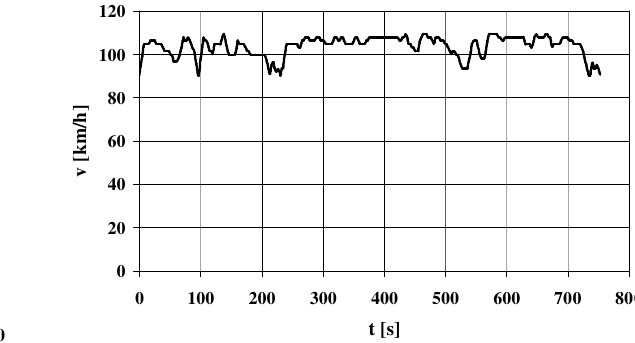
Fig. 2. Speed curve – v in the NEDC test cycle